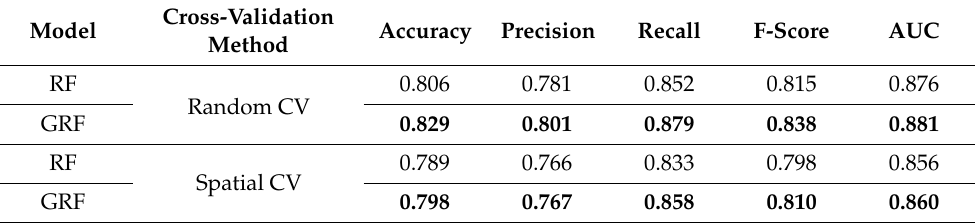
Table 5. Performances of RF and GRF on the validation data using random CV and spatial